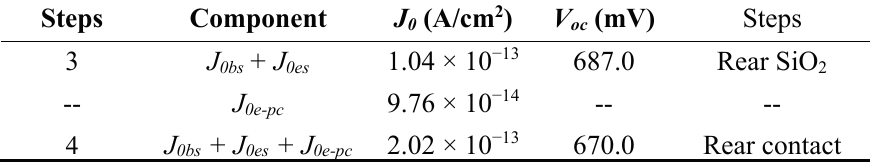
Table 6. J 0 and V oc values of the thin silicon solar cell after rear surface metallization. J 0e-pc is the reverse saturation current density introduced by the point contact on the rear